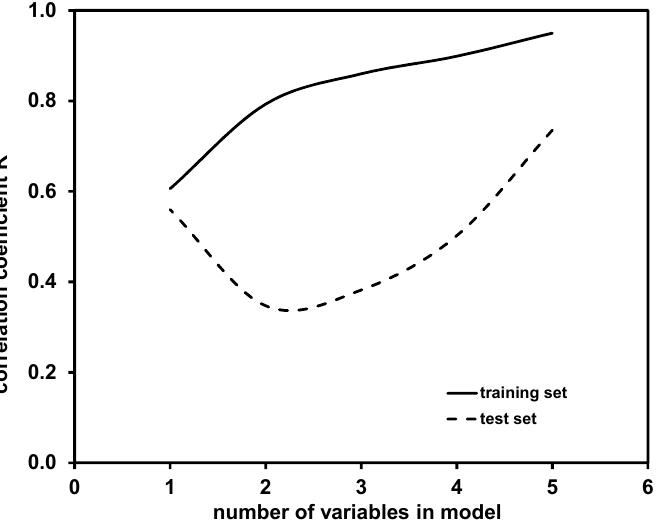
Figure 3. Comparison of correlation coefficients R obtained for training and test set by one- to five-variable models for modeling of K coefficient.